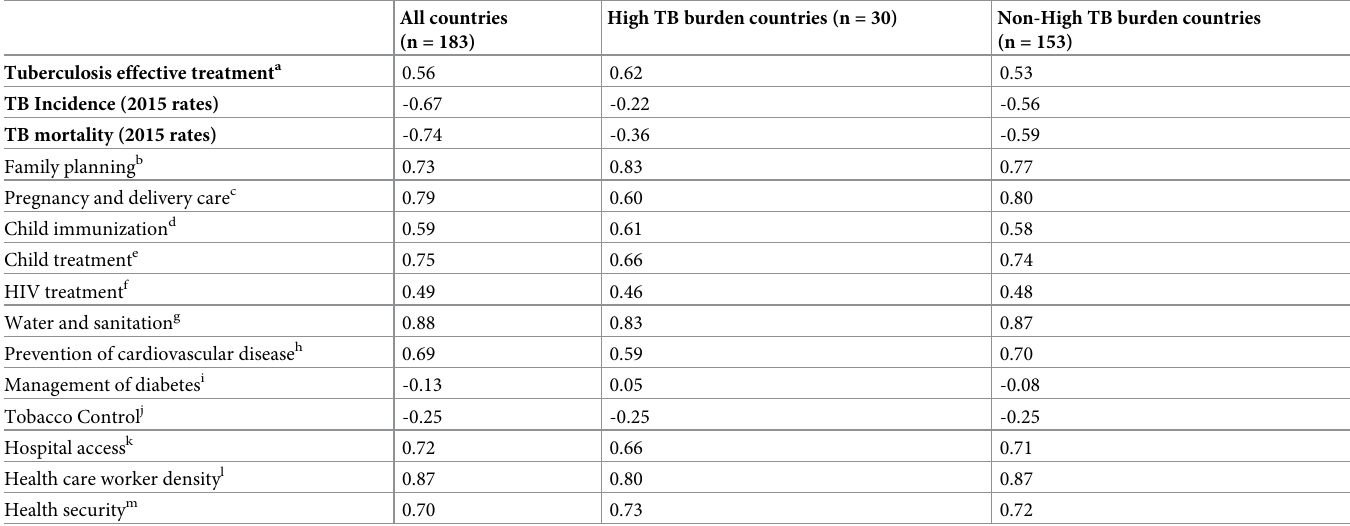
Table 1. Pearson correlations for fifteen service coverage indicators, TB incidence and TB mortality, with UHC Service Coverage Index Score across 183 countries. All countries (n = 183)